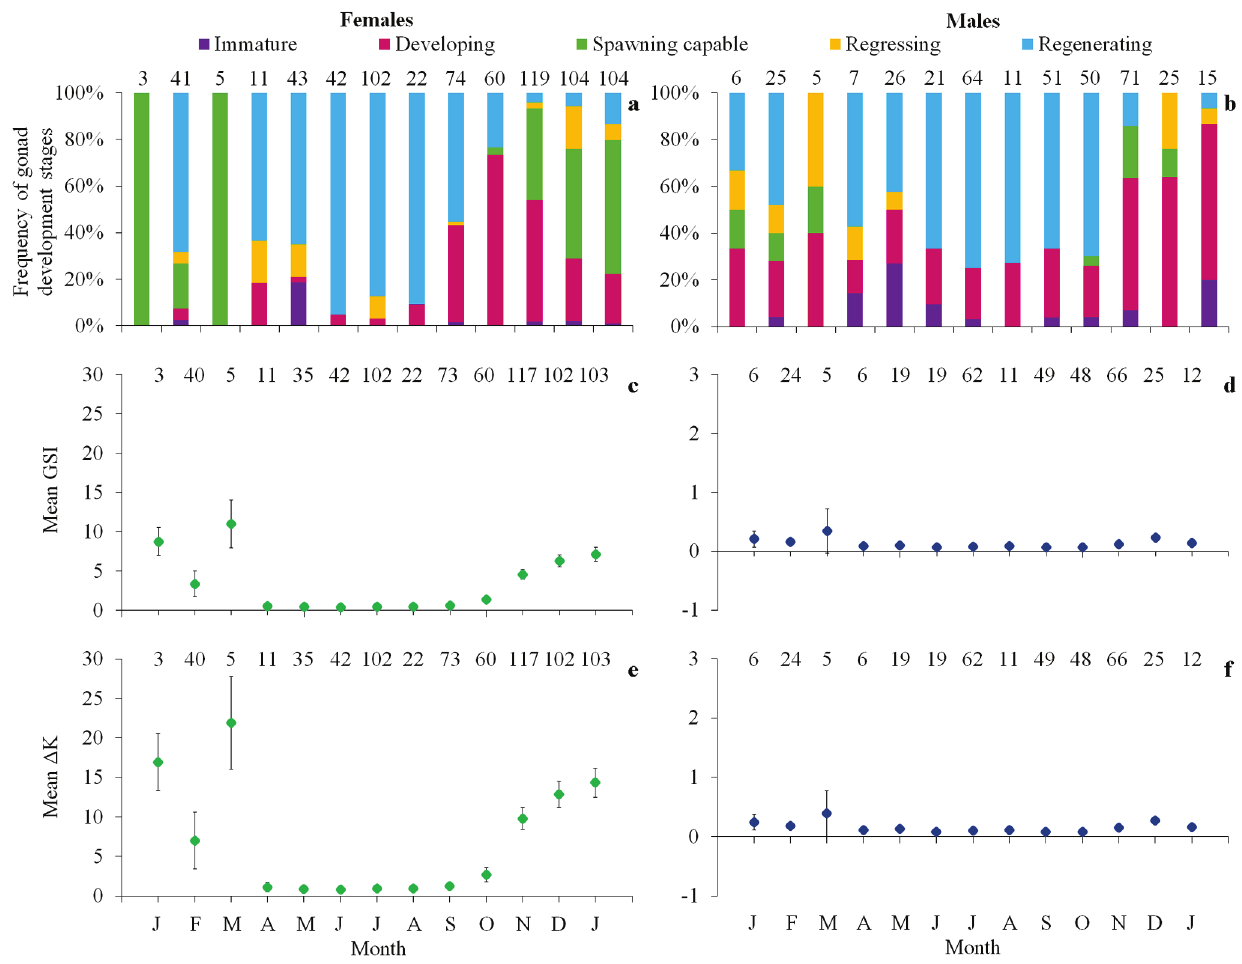
Fig. 3. Monthly distribution of the gonad development stages, GSI (mean ± CI) and ΔK (mean ± CI) of Genidens genidens females and males in Guanabara Bay, Rio de Janeiro, Brazil from January 2014 to January 2015. a. frequency of gonad de- velopment stages of females (N = 730); b. frequency of gonad development stages of males (N = 377); c. females GSI (N = 715); d. males GSI (N = 352); e. females ΔK (N = 715); f. males ΔK (N = 352). The values at the top of the graphs indicate the number of individuals caught each month. The juveniles were excluded from GSI and ΔK analyzes.